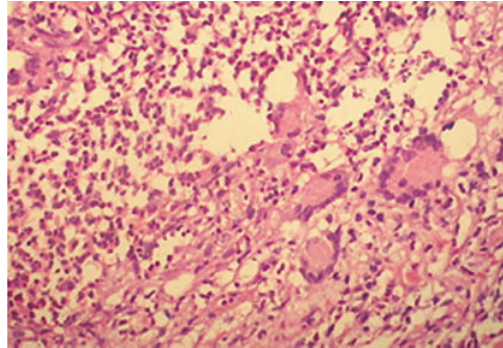
Figure 2: Histological examination revealed multiple confluent necrotizing and nonnecrotizing granulomas with giant cells (mult- inucleated and Langhans’